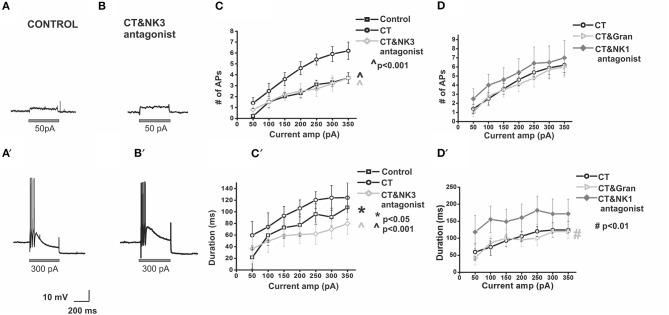
Co-incubation of CT with a NK3 but not NK1 or 5-HT3 receptor antagonist prevents CT-induced hyperexcitability in myenteric AH neurons. Electrophysiological recordings are displayed showing a control neuron (A) and a CT (12.5 μg/ml) + NK3 (100 nM) antagonist-treated neuron (B) at 50 pA (A,B) and 300 pA (A′,B′) current pulses. These neurons exhibit comparable action potential firing. Pre-treatment with the CT + NK3 antagonist significantly reduced the number of APs fired (C) (∧p < 0.001) during depolarization's and their firing duration (C′) (∧p < 0.001), over a range of current pulse amplitudes (effect shown graphically in grayscale). This effect was not observed following the CT + NK1 antagonist (100 nM) or CT + 5-HT3 antagonist (1 μM) co-incubation (D,D′). Instead, duration of action potential firing was increased with the addition of the NK1 receptor antagonist (#p < 0.01) (D′).